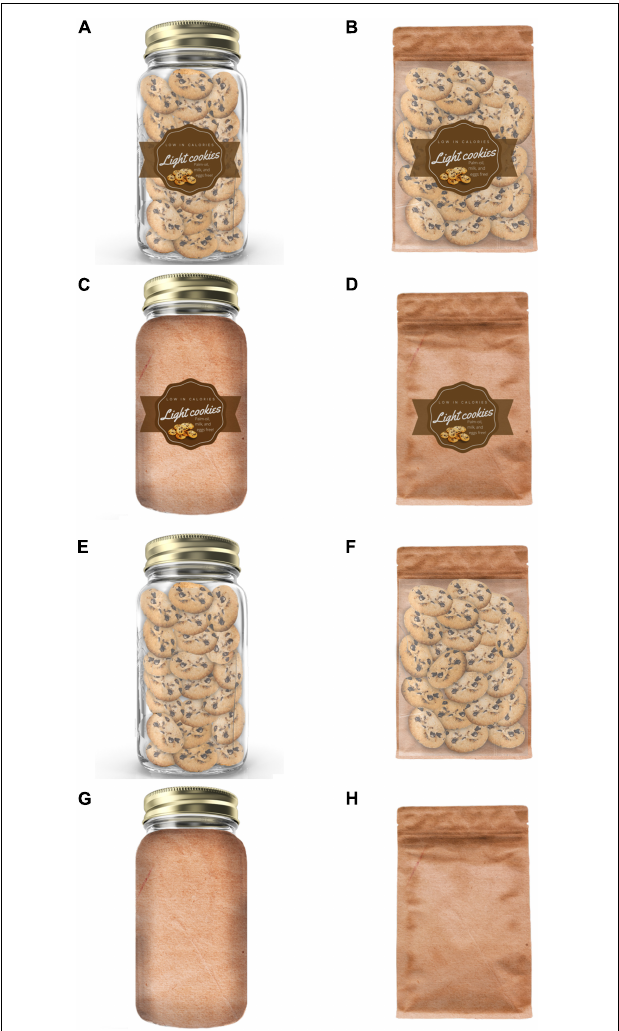
FIGURE 1 | The eight experimental packages [labeled transparent jar (A) , labeled transparent bag (B) , labeled opaque jar (C) , labeled opaque bag (D) , unlabeled transparent jar (E) , unlabeled transparent bag (F) , unlabeled opaque jar (G) , unlabeled opaque bag (H) ]. The packages were presented scaled to match in size, and large enough in order for the participants be able to clearly see all the available information present in the label [the latter only when applicable, since (E–H) versions were